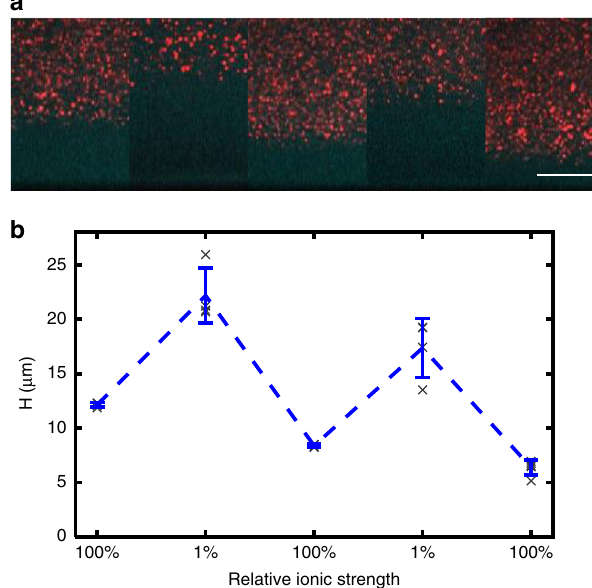
Fig. 3 Stimulus responsiveness and reversibility. a Brush height during a series of solvent swaps from 133 to 1.33 mM for a brush previously grown for 16 h. Scale bar, 10 µ m. b Quanti fi cation of the brush height shows that at ultra-low ionic strengths, the brush stretches out by nearly 200%, peaking at 22.0 ± 2.5 µ m (st. dev.) during the fi rst exchange. While the brush swelling and shrinking is reversible, the repeated handling (and tension induced by stretching) leads to some loss of the HA, which is weakly bound to the HA synthase. As a consequence, a gradual decrease in the overall brush height is observed. Each gray data point corresponds to fi ve independent measurements (211 × 211 µ m 2 area) from one sample. Blue data points show the mean and st.